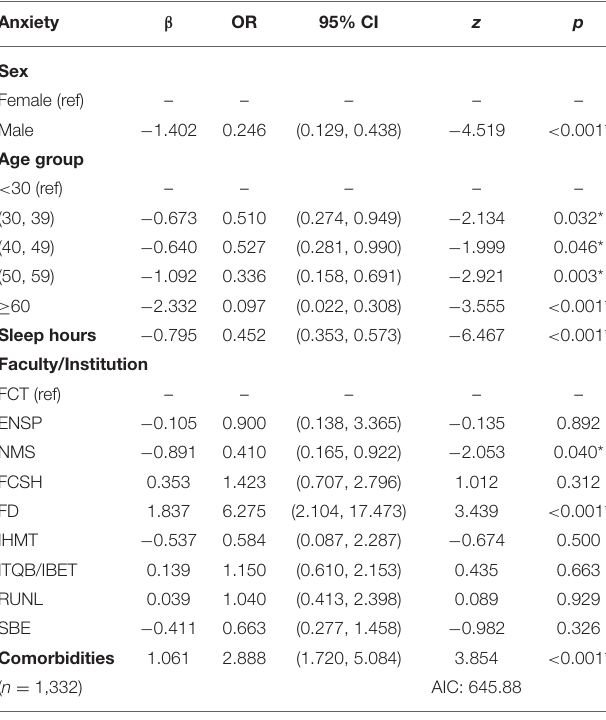
TABLE 6 | Logistic regression analysis to identify factors associated with the presence of anxiety symptoms in NOVA employees.